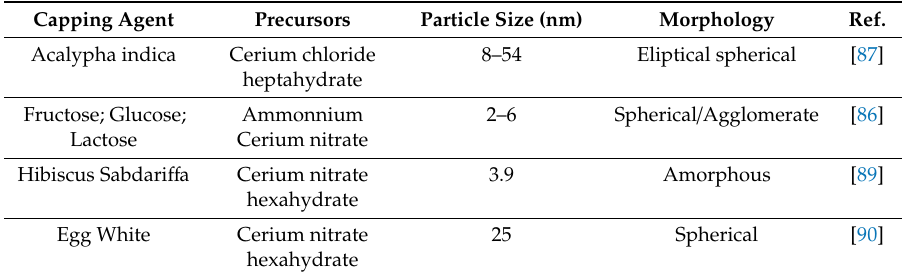
Table 4. Table showing the synthesis of cerium oxide nanoparticles using the green synthesis